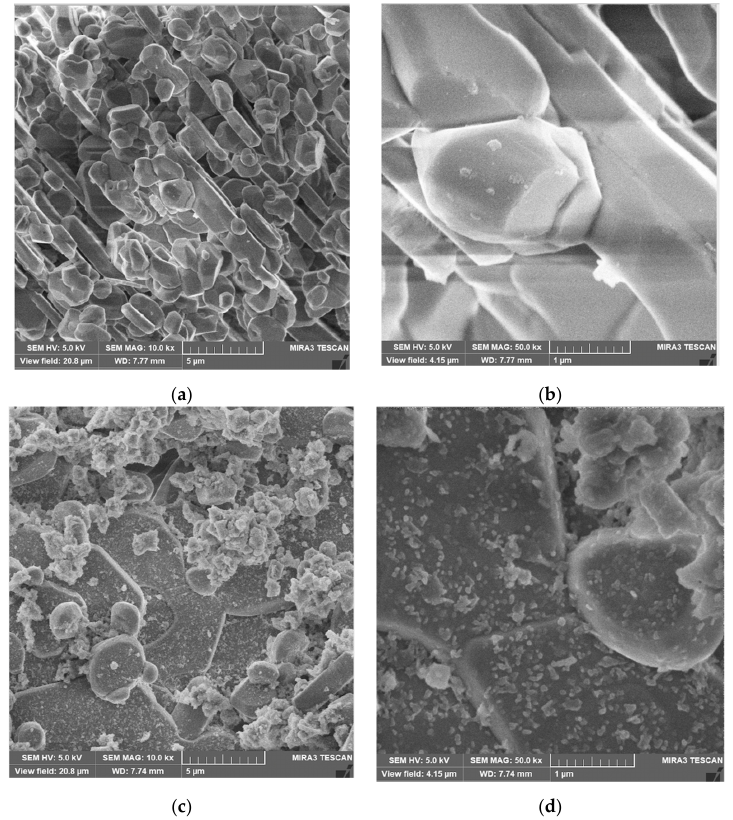
Figure 2. Scanning electron microscopy (SEM) images of ( a , b ) Reference Al 2 O 3 and ( c , d ) 75%CaO/25%Al 2 O 3.